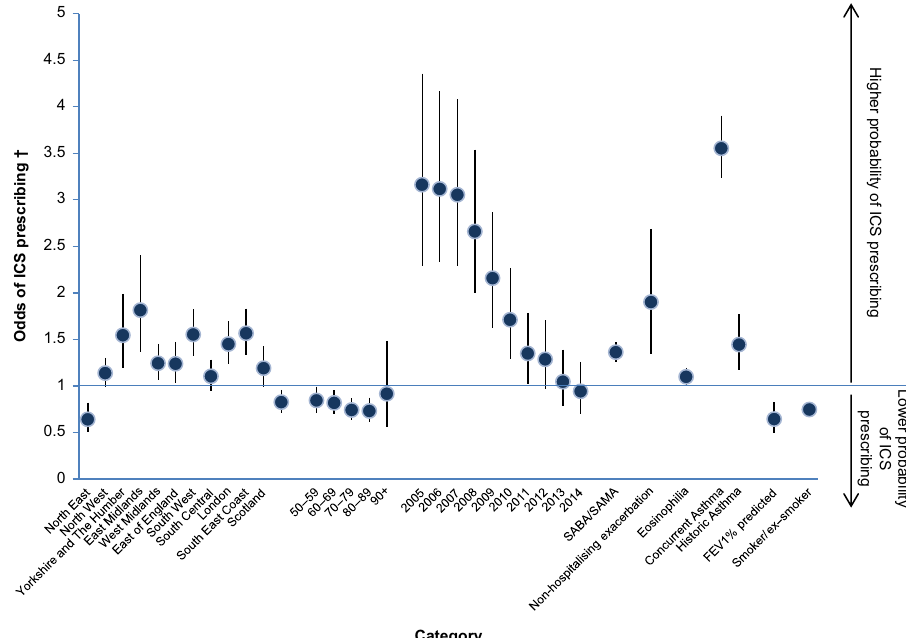
Fig. 3 Logistic regression model — odds of prescribing ICS to GOLD A/B COPD patients at diagnosis (overall cohort). SABA short-acting beta- agonists, SAMA short-acting muscarinic antagonists. † Comparisons were made against a reference category in the case of region (Wales), age (40 – 49 years), and year of diagnosis